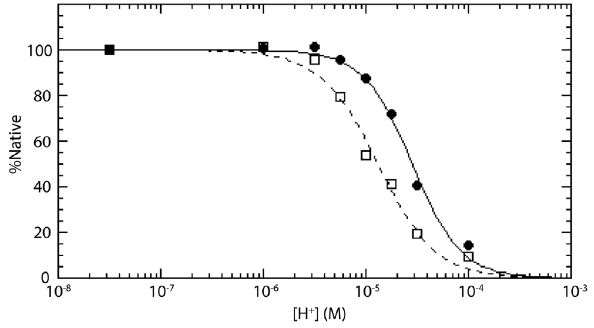
Figure 3. TBHQ stabilizes the neutral pH conformation of H7 HA. Limited proteolysis experiment for H7 HA in the presence (open squares, dotted line) and absence (filled circles, solid line) of TBHQ at different pH. The curves correspond to fits using [H + ] mp =1.30 6 10 2 5 and n=1.6 in the absence of TBHQ and [H + ] mp =2.83 6 10 2 5 and n=1.8 in the presence of TBHQ (c.f. Experimental